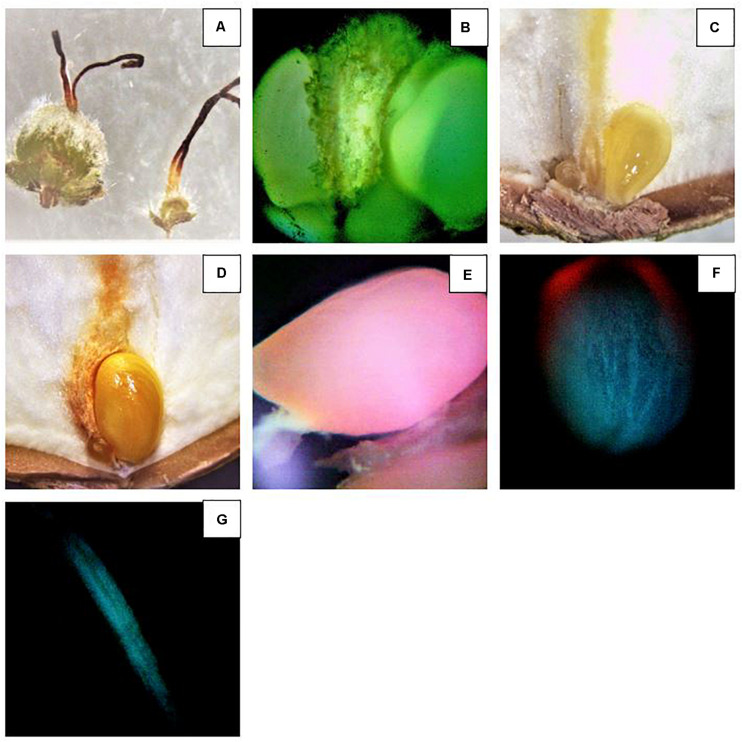
Investigation of the ovule development using disodium fluorescein. (A) Comparison between an abortive ovary (right) and developing ovary (left). (B) Intense fluorescence observed in two developing ovules. (C) Two ovules. The one on the right is developing and the other on the left side, much dimmer, ceasing the development. Note the yellowish color of the funicle and developing ovary after disodium fluorescein absorption. (D) Two ovules. The one on the right continue to develop and the other on the left side ceased the development. (E–G) Reduced transport of disodium fluorescein in immature ovules ceasing the development (E,F) and a funicle where the ovule completely ceased the development.